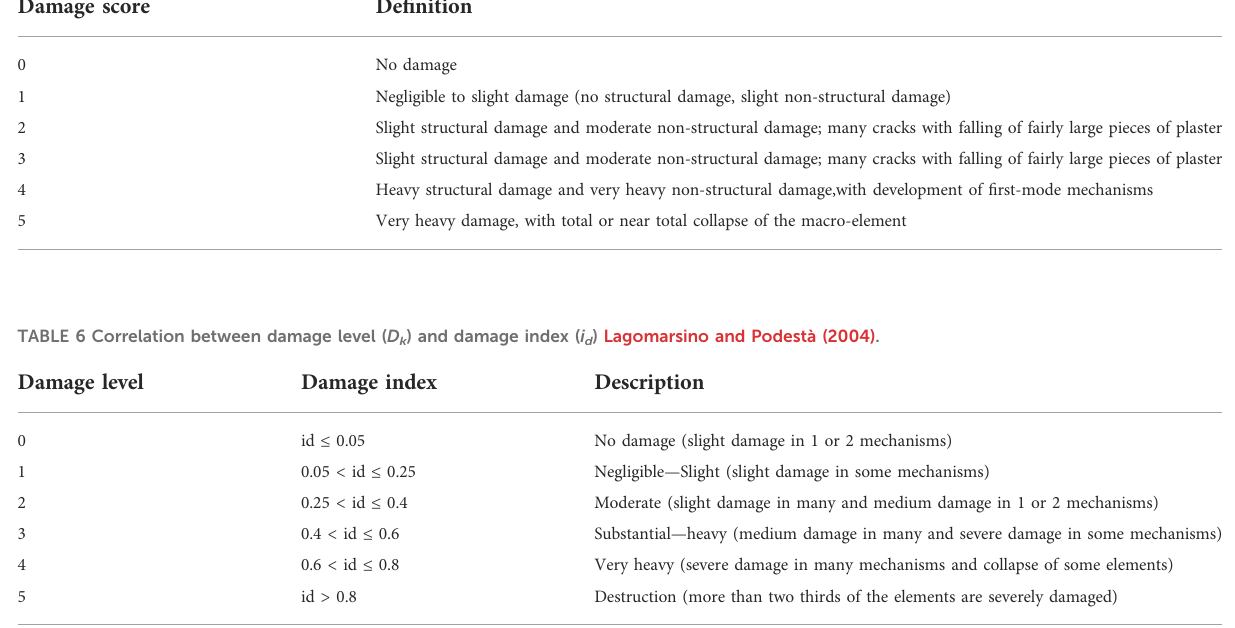
TABLE 5 Damage score ( d k ) values De Matteis et al. (2016).